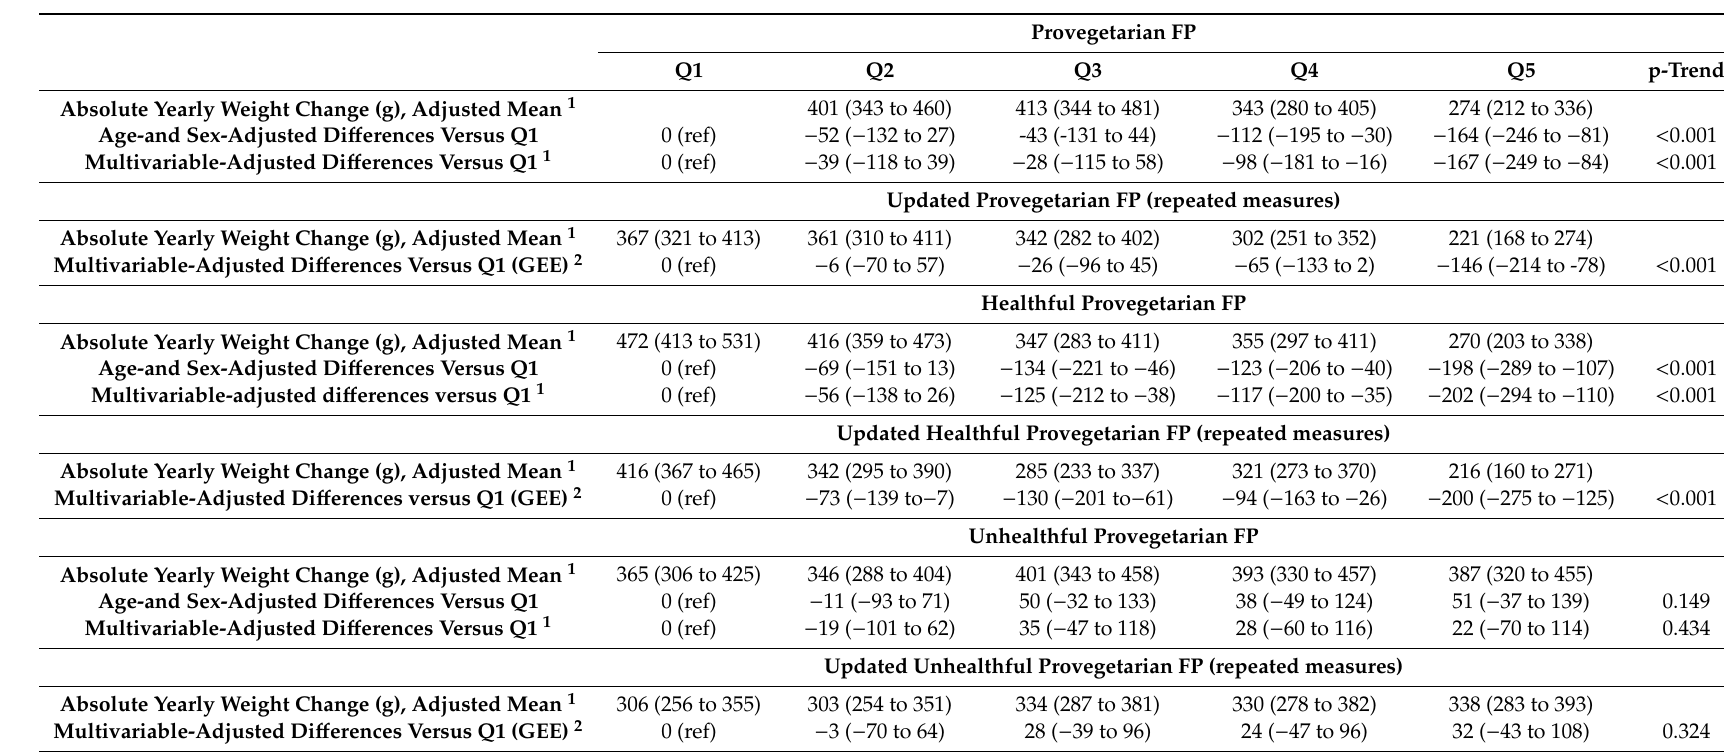
Table 3. Estimates (di ff erences and 95% confidence intervals) for average yearly weight change (g / y) according to updated quintiles (Q) of adherence to a